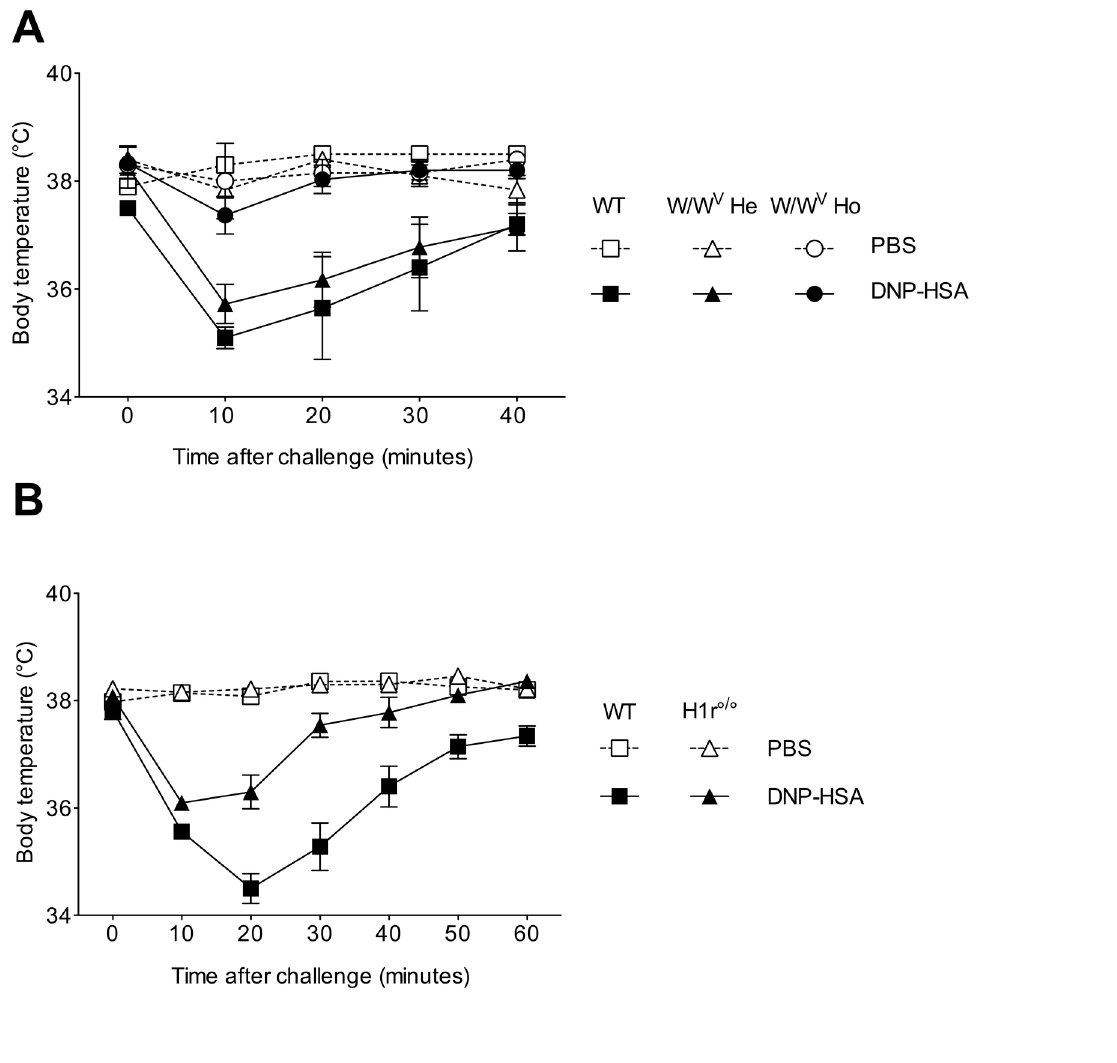
Figure 1. Passive systemic anaphylaxis (PSA) depends on mast cells and histamine. PSA was induced by i.v. sensitization with 10 µg of anti-DNP IgE and challenge 24hrs later with 500 µg of DNP-HSA ( black symbols ) or PBS as control ( white symbols ) in MC-deficient mice homozygotes mutants (W/W v Ho) ( circles ), heterozygotes (W/W v He) ( triangles ) and their WT littermates (+/+) ( squares ) (A) and in Histamine receptor-1-deficient (HR1 °/° ) ( triangles ) and WT B6 mice ( squares ) mice (B). Body temperature was measured at various time points after challenge. Data are presented as mean (± SEM) of body temperature (n= 5 mice/group).